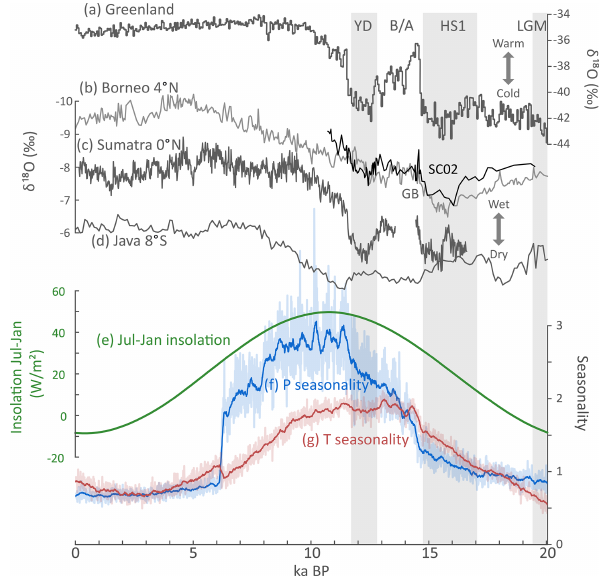
Figure 2. Long-term transient changes in temperature and hydrocli- mate based on proxy evidence in comparison to seasonality changes in terms of orbital forcing (2 ◦ N) and simulated precipitation ( P ) and temperature ( T ). (a) Greenland (NGRIP) ice core δ 18 O in- dicative of NH high latitude temperature (NGRIP members, 2004). (b) speleothem δ 18 O, indicative of precipitation amount, from Bor- neo (Partin et al., 2007: GB, gray, and Buckingham et al., 2022: SC02, black); (c) Sumatra (Wurtzel et al., 2018); and (d) Java (Ayliffe et al., 2013; Griffiths et al., 2009). (e) Insolation difference between NH winter and summer calculated from July minus Jan- uary insolation from 2 ◦ N (Laskar et al., 2004). Seasonality is cal- culated as JJA / DJF for precipitation ( f , blue) and JJA-DJF for tem- perature ( g , red) based on the TRACE simulation (He, 2011) over Sunda (3 ◦ S–1 ◦ N, 100–104 ◦ E), with 19- point running mean in bright colors and each data point in pale colors. The strong changes in seasonality closely follow the orbital forcing seasonality, which is evident in climate model simulations but not visible in the sea- sonally integrated proxy